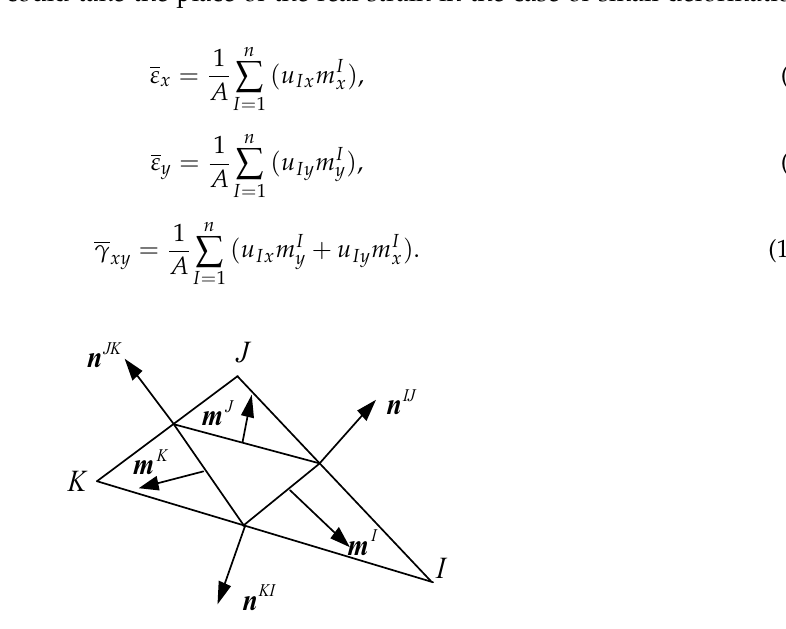
Figure 2. Construction of a triangular element stiffness.